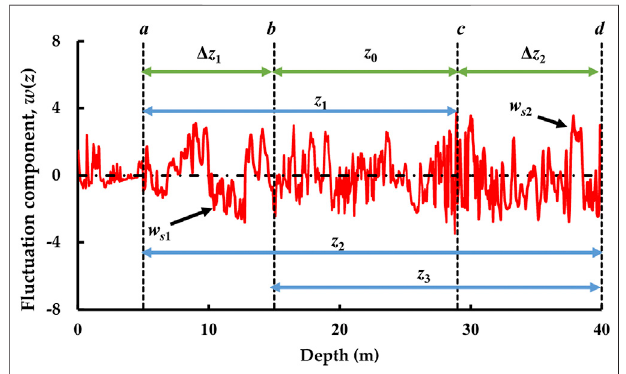
FIGURE 3 | Calculation scheme of the correlation between two